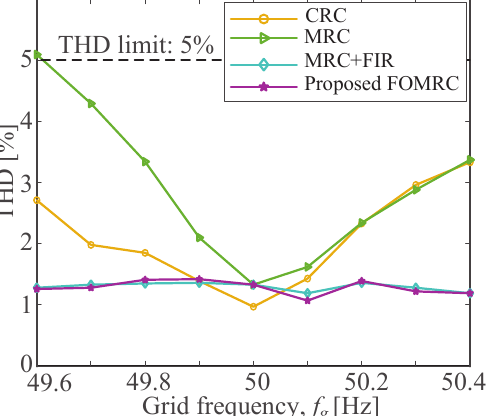
Figure 11. Comparison of THD results for the above control systems.